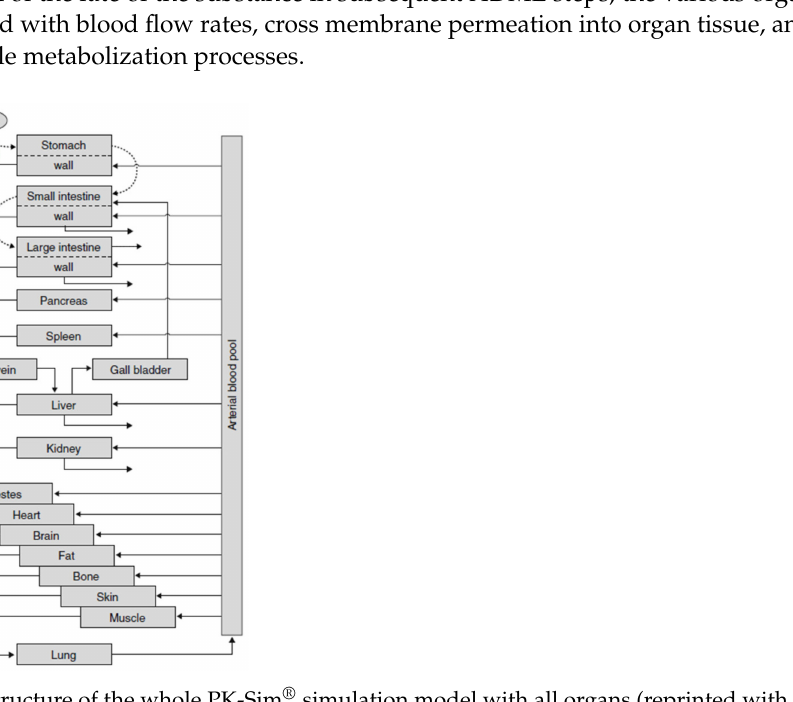
Figure 4. Structure of the whole PK-Sim ® simulation model with all organs (reprinted with permis- sion from [48], Springer Nature, 2008). IV = intravenous, PO =